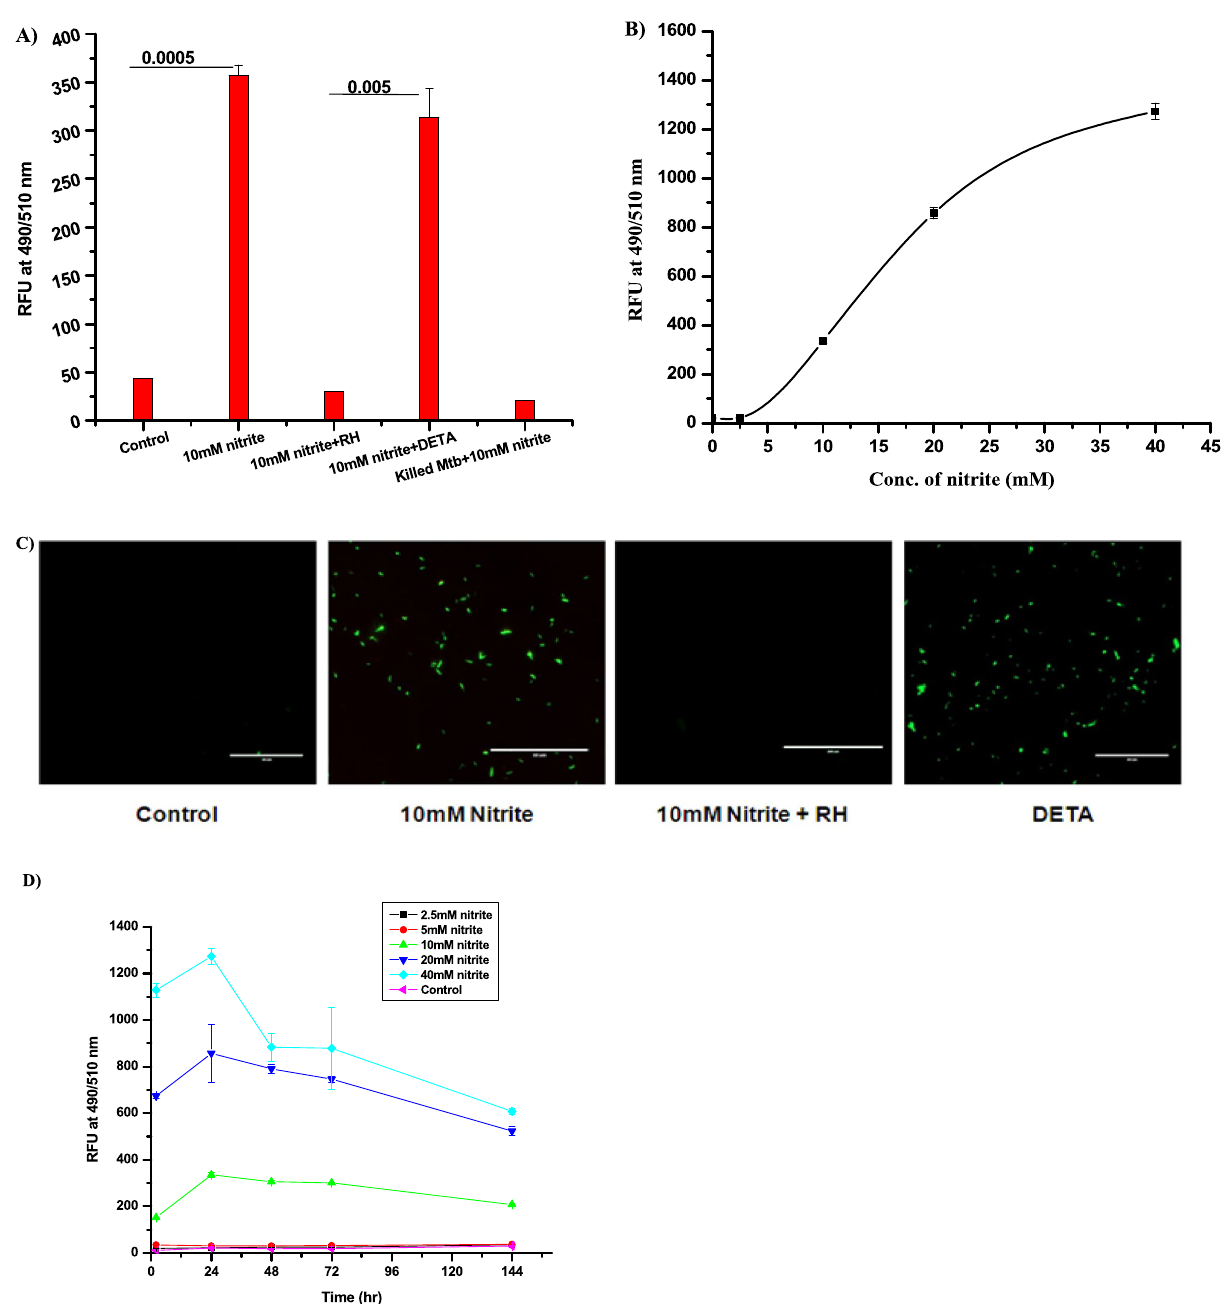
Figure 1. NO production in Mycobacterium tuberculosis cells in the presence of nitrite: Log phase Mtb cells were treated with ( A ) nitrite (10 mM), nitrite (10 mM) along with rutin hydrate (1 µM) and DETA NO (50 µM), killed Mtb (10 mM of nitrite), ( B ) In presence of different nitrite concentration ( C ) Fluorescence microscopy image of nitrite treated Mtb cells captured by EVOS microscope as mention in “Materials and Methods section” (Scale bar 50 μm). ( D ) Time kinetics of NO production in Mtb cells at different concentration of nitrite with (black filled square) 2.5 mM, (black filled circle) 5 mM, (black filled triangle) 10 mM (black filled inverted triangle) 20 mM, (black filled daimond) 40 mM nitrite and, (black filled left side triangle) untreated as control respectively. NO production in Mtb cells was detected by using DAF2DA dye as relative fluorescence unit at 490/510 nm wavelength. The data shown are representative as a mean of three independent experiments ±